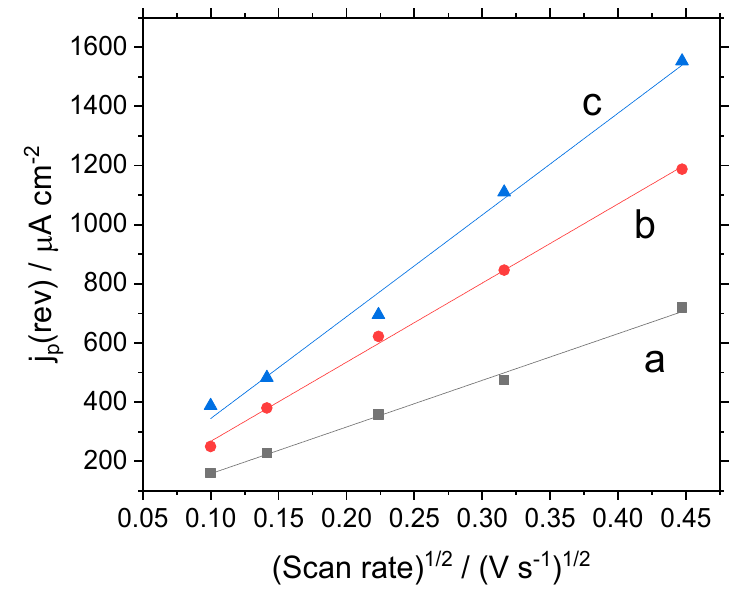
Figure 5. Randles–Sevcik plot for ferrocene oxidation with different GC ‐ modified electrodes: ( a ) SiO 2 ; ( b ) SWCNT@SiO 2 ; ( c ) SWCNT@SiO 2 ‐ PEDOT ‐ PSS.